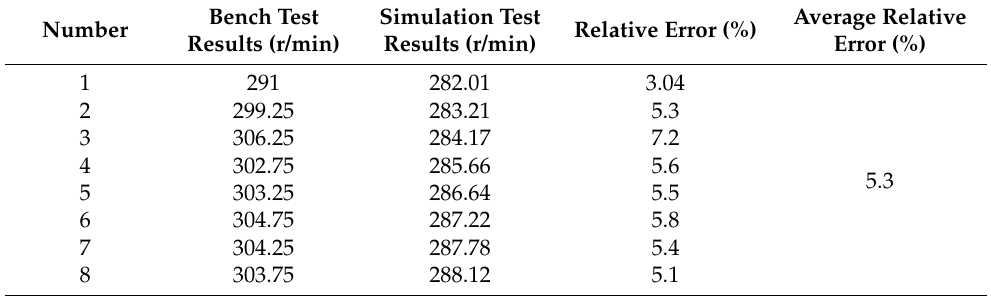
Table 2. Results Table 2. Results comparison.